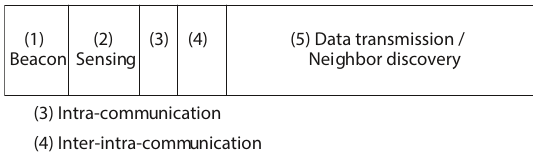
Figure 7. CB-MAC superframe